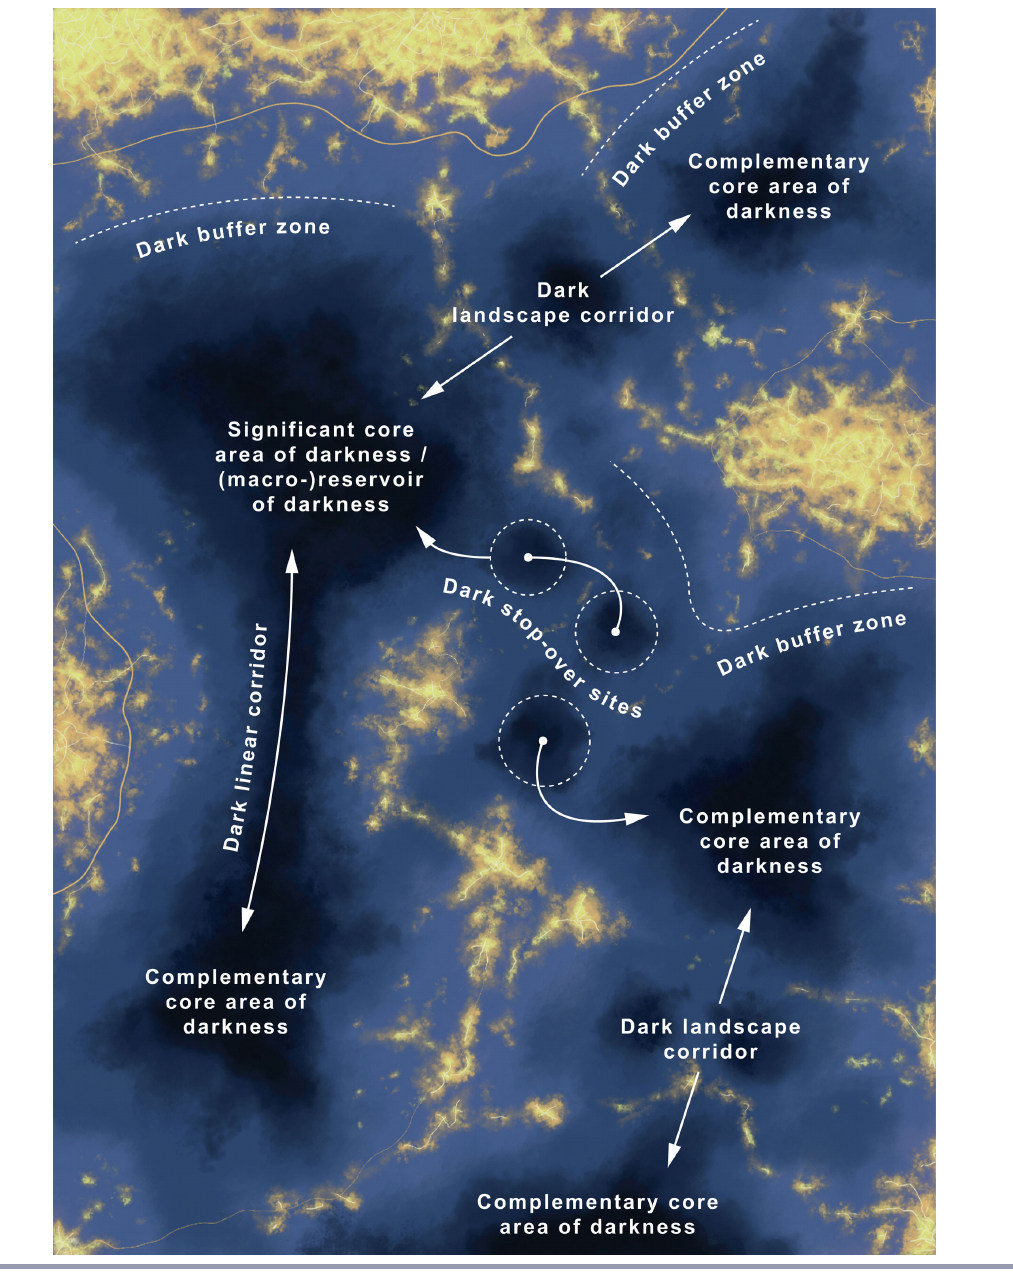
Fig. 2 . Conceptual blueprint of the structural components of the dark ecological